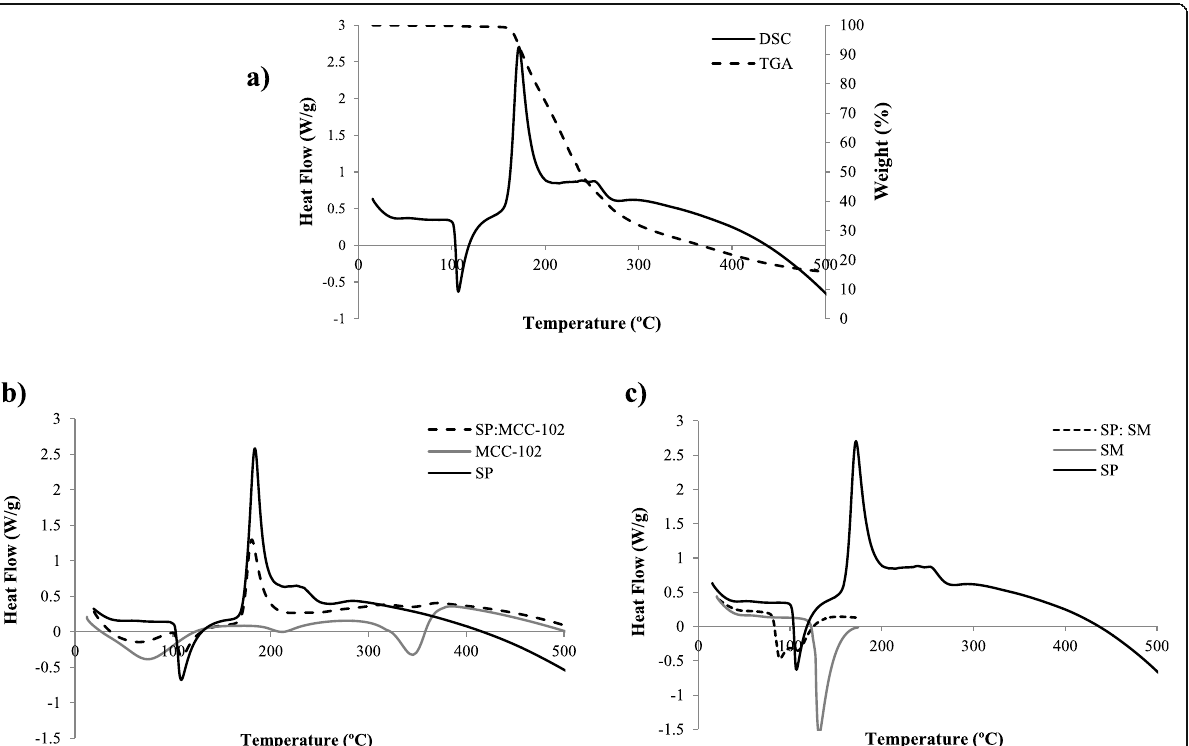
Fig. 5 Thermal analysis of SP, MCC-102, SM, and physical mixtures: a TGA and DSC curves of SP, b DSC thermograms of SP:MCC-102 (1:1) physical mixture and the pure materials, c DSC curves of SP:SM (1:1) physical mixture and the pure materials